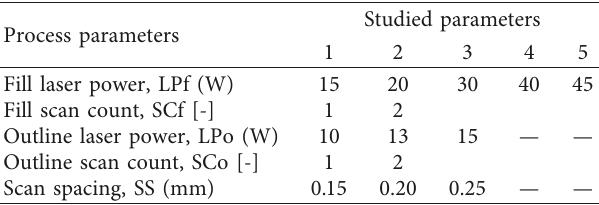
Table 1: Process parameters and their values. Process parameters